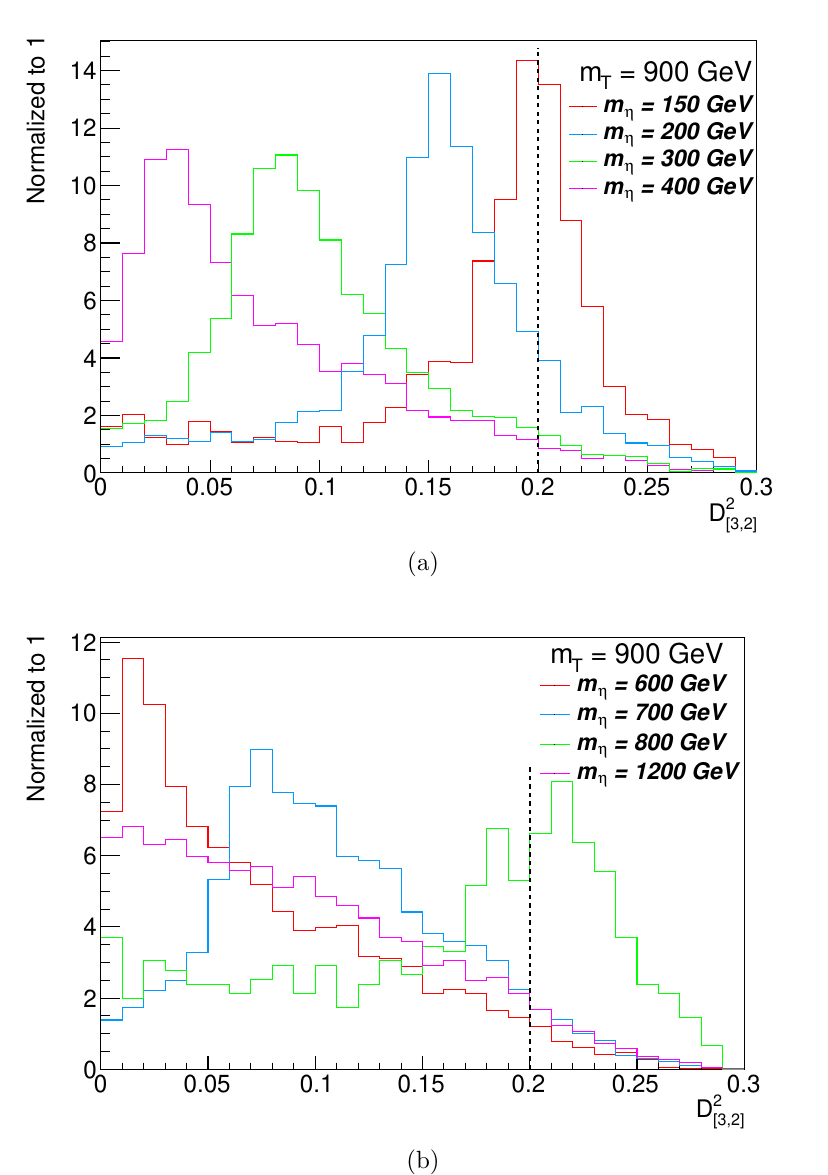
Figure 4. The D 2 variable distributions for signal triplets with top partner mass of 900 GeV and [3 ; 2] various scalar masses. The black dashed line represent the cut placed on D 2 below this value) for this particular top partner